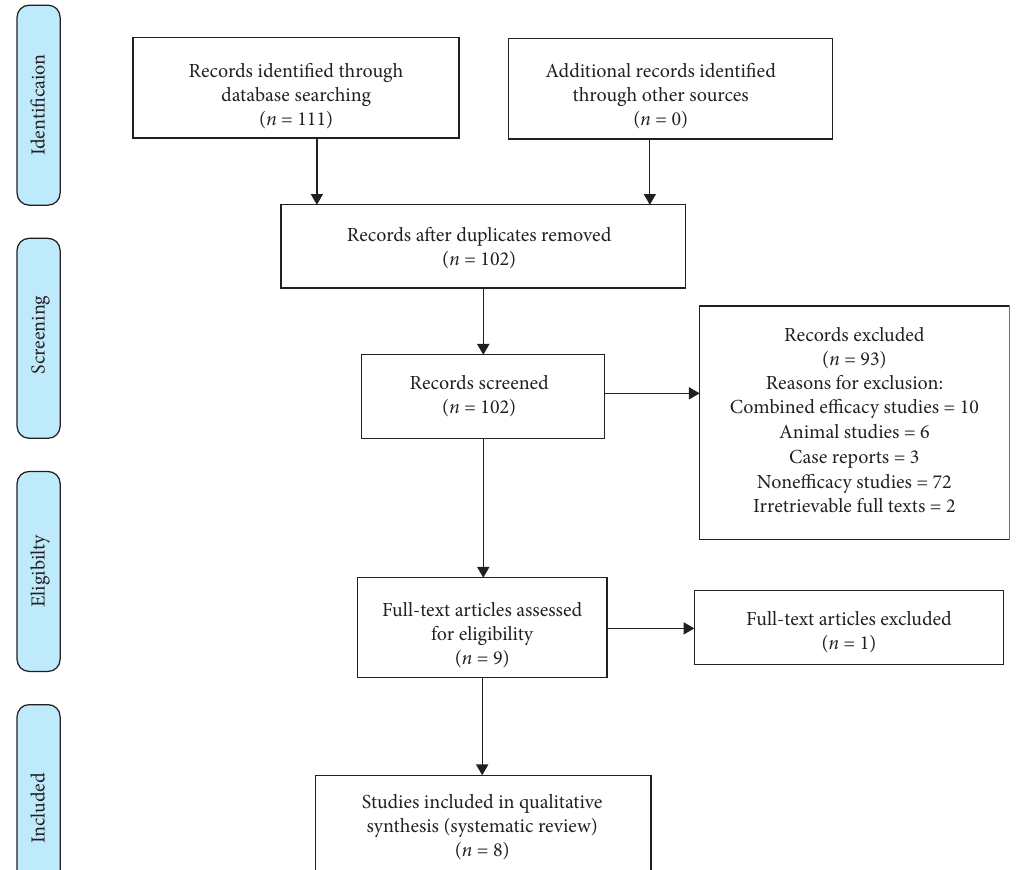
Figure 2: PRISMA flow diagram for study selection for the systematic review.